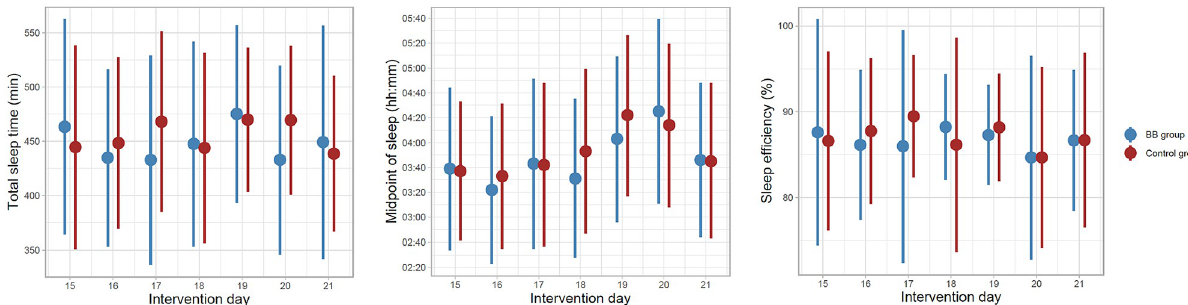
Fig 3. Daily sleep during the second intervention period (subjective data). The pattern of daily changes in total sleep time, midpoint of sleep and sleep efficiency presented with mean and standard deviation for the second intervention